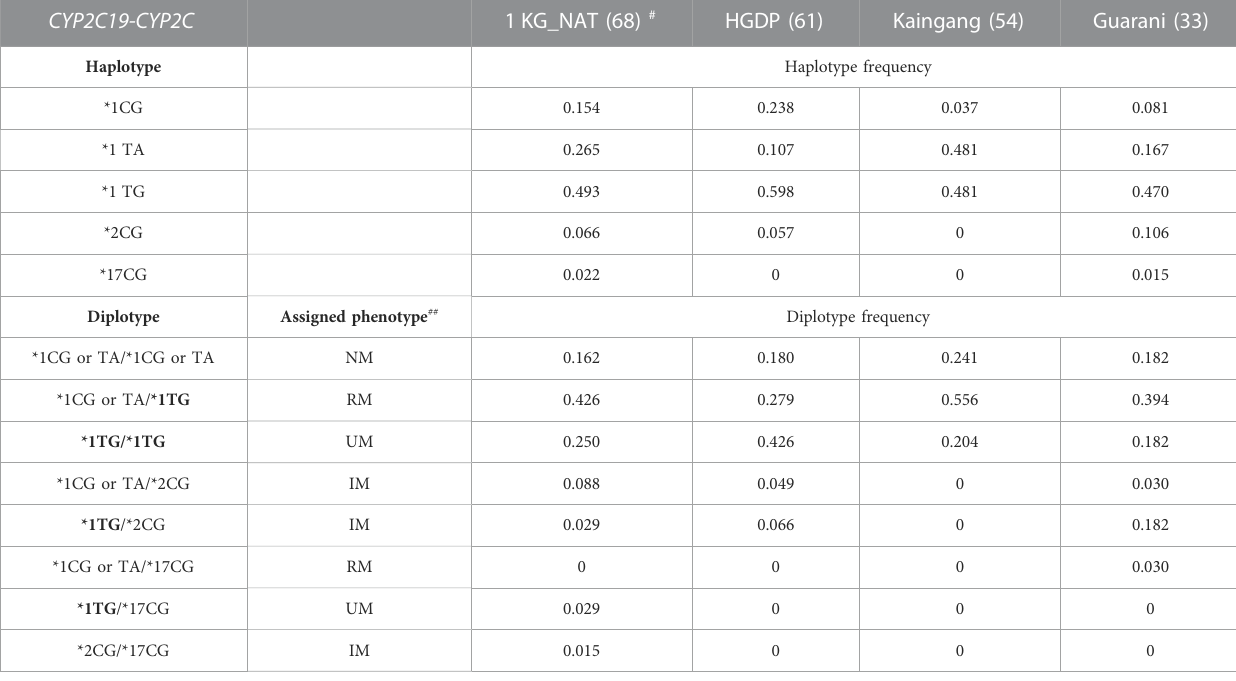
TABLE 3 Distribution of CYP2C19-CYP2C diplotypes and assigned CYP2C19